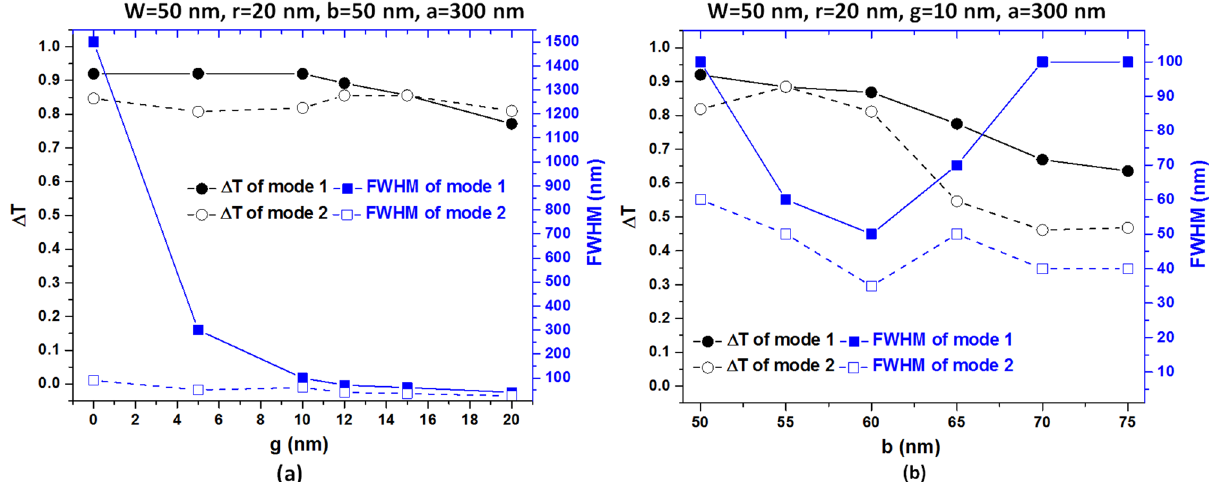
Figure 7. Dip strength (∆T) and FWHM of the proposed type 3 structure in mode 1 and mode 2 for ( a ) varying g in the range of (0, 5, 10, 12,15, 20) nm, and ( b ) varying b in the range of 50–75 nm in the step of 5 nm. The other structural parameters are at the top of the